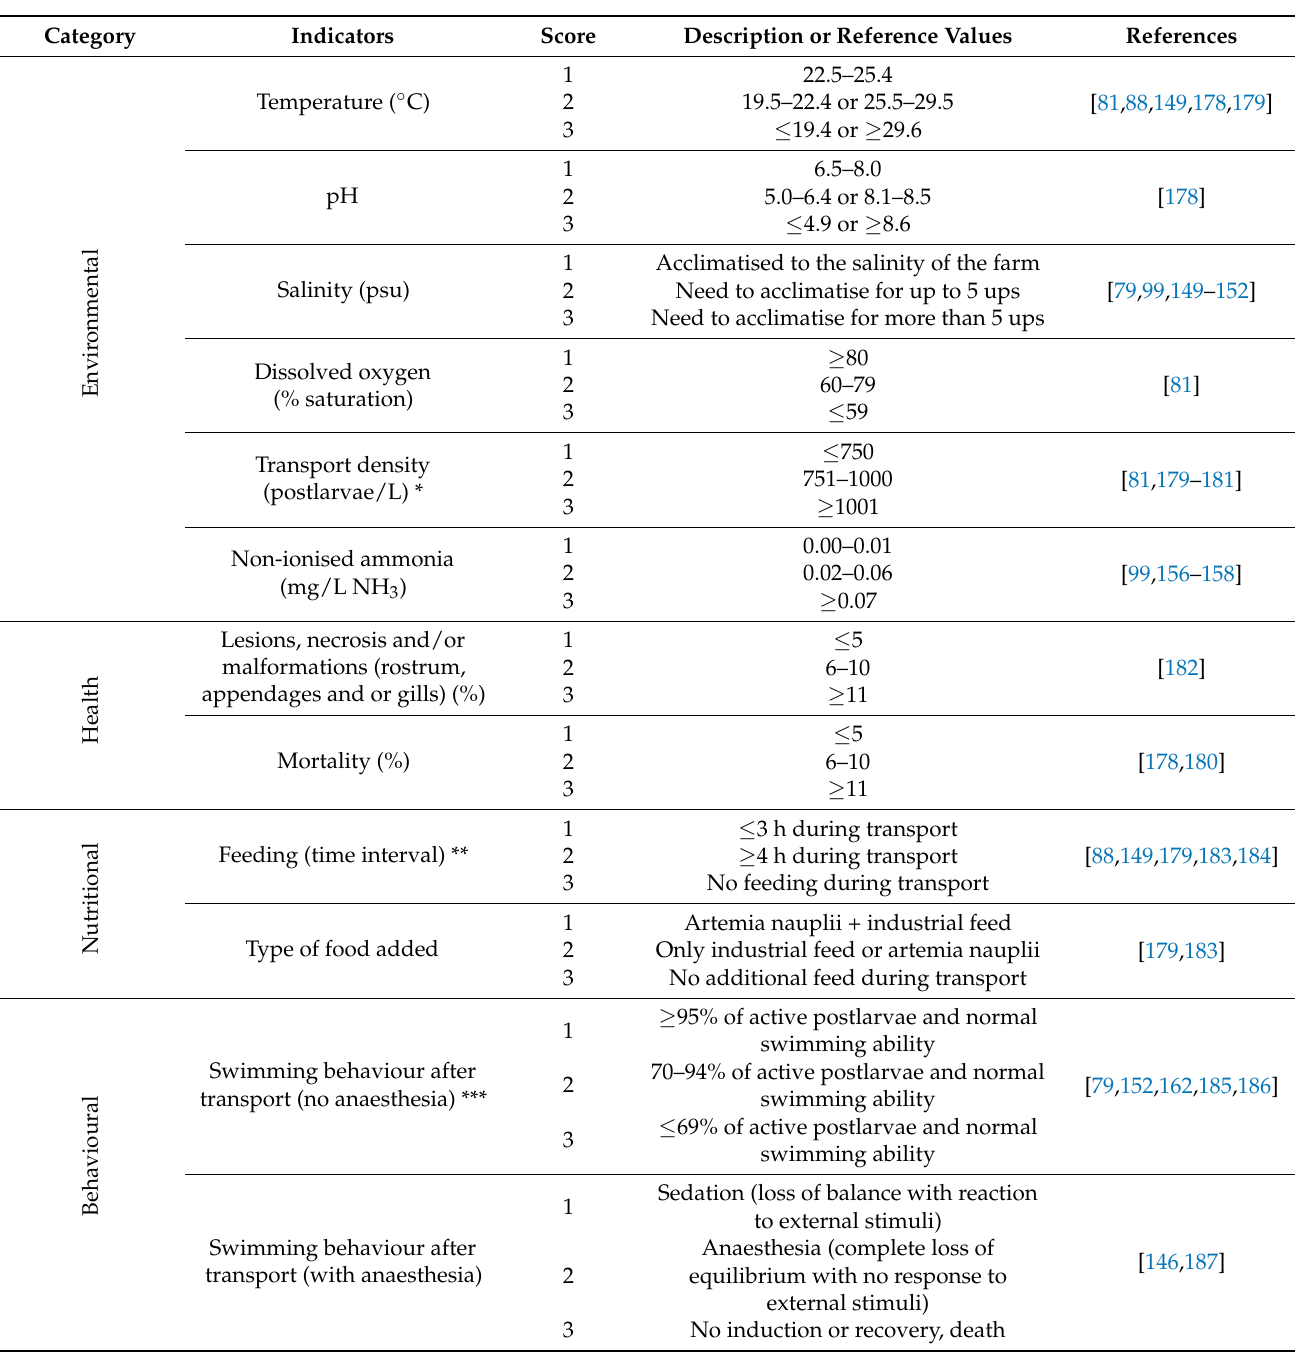
Table 10. Indicator for the transport of postlarvae of Penaeus vannamei